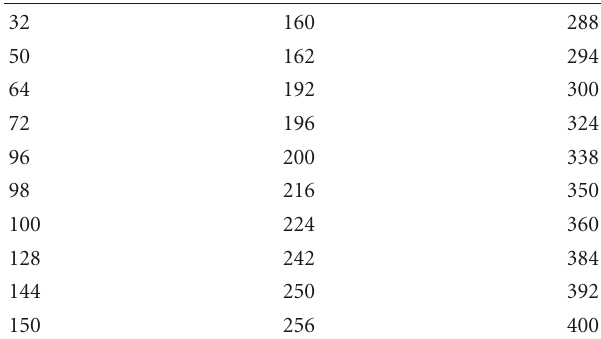
Table 1: Values of B T for which codes can be designed with the proposed algorithm ( M = 4 and Δ f Δ t =